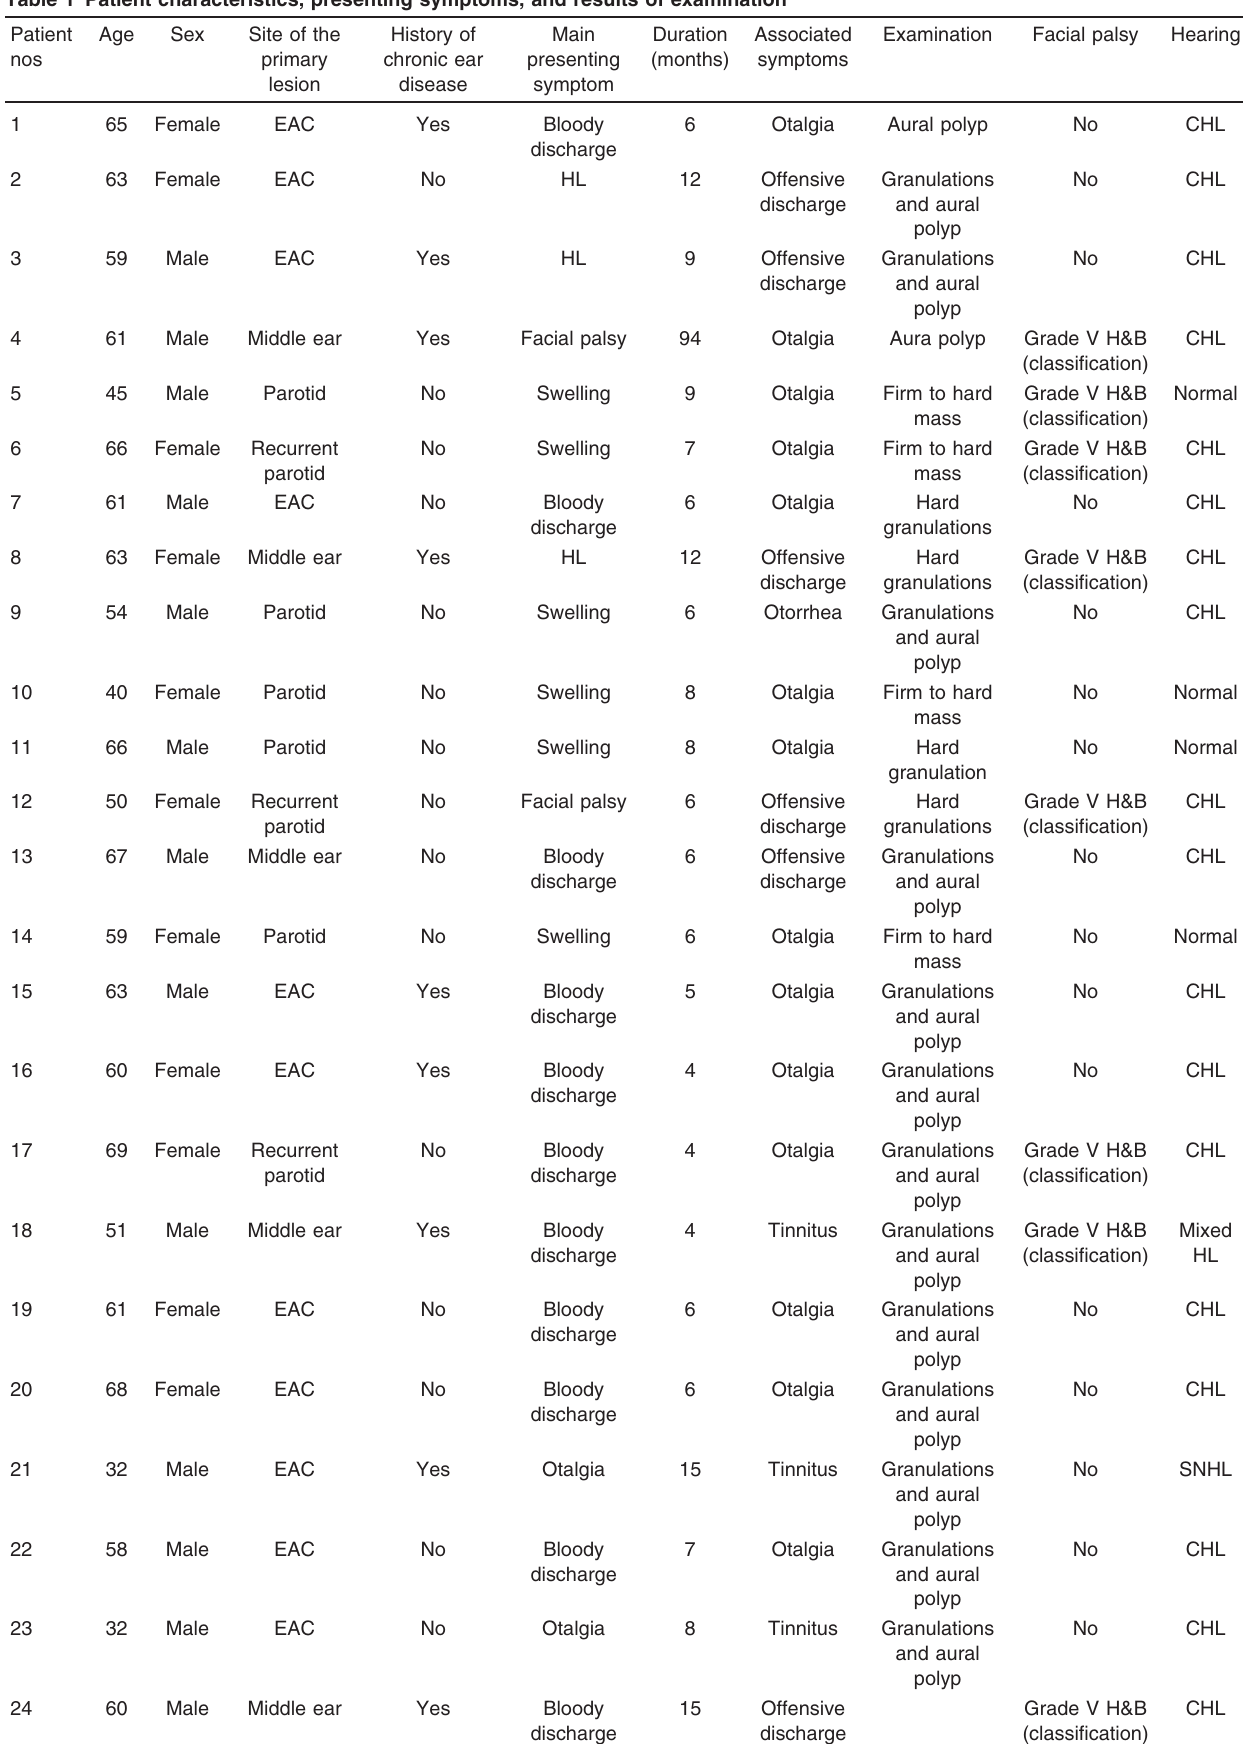
Table 1 Patient characteristics, presenting symptoms, and results of examination Patient